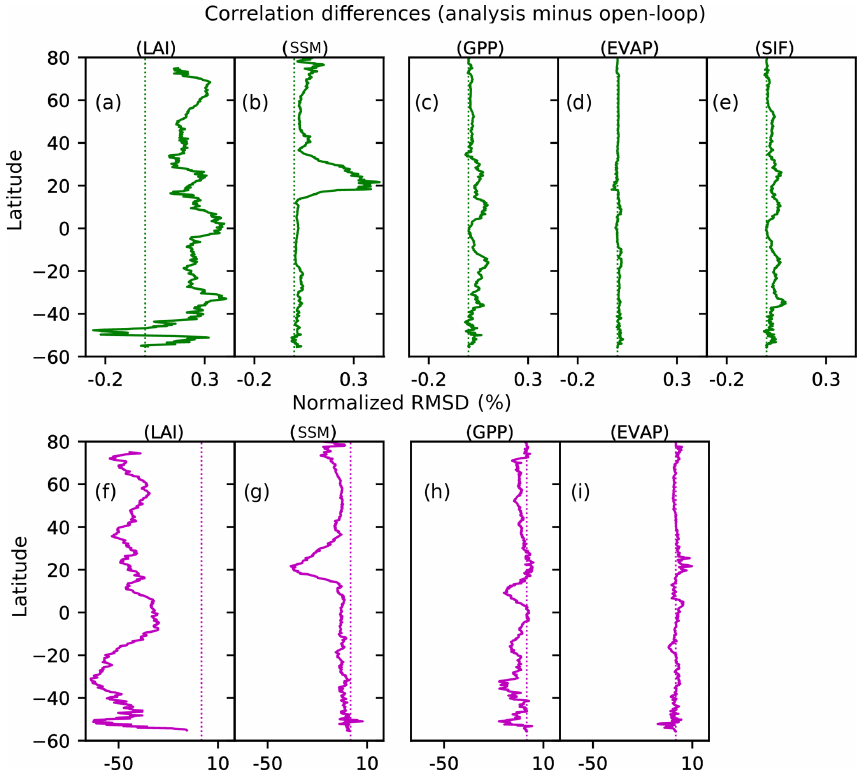
Figure 5. Latitudinal plots of score differences (analysis minus open-loop) for correlations (a–e) and normalized RMSD (f–i) for LAI (a, f) , SSM (b, g) , GPP (c, h) , EVAP (d, i) and SIF ( e , correlations only). Scores are computed based on the monthly average over